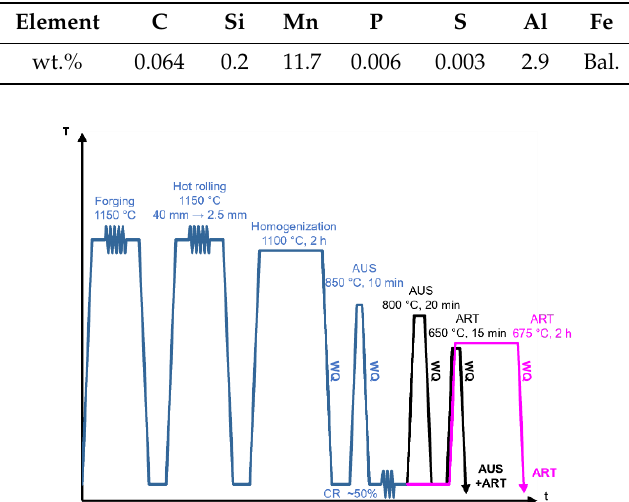
Table 1. Chemical composition of the investigated material as determined by wet chemical analysis.